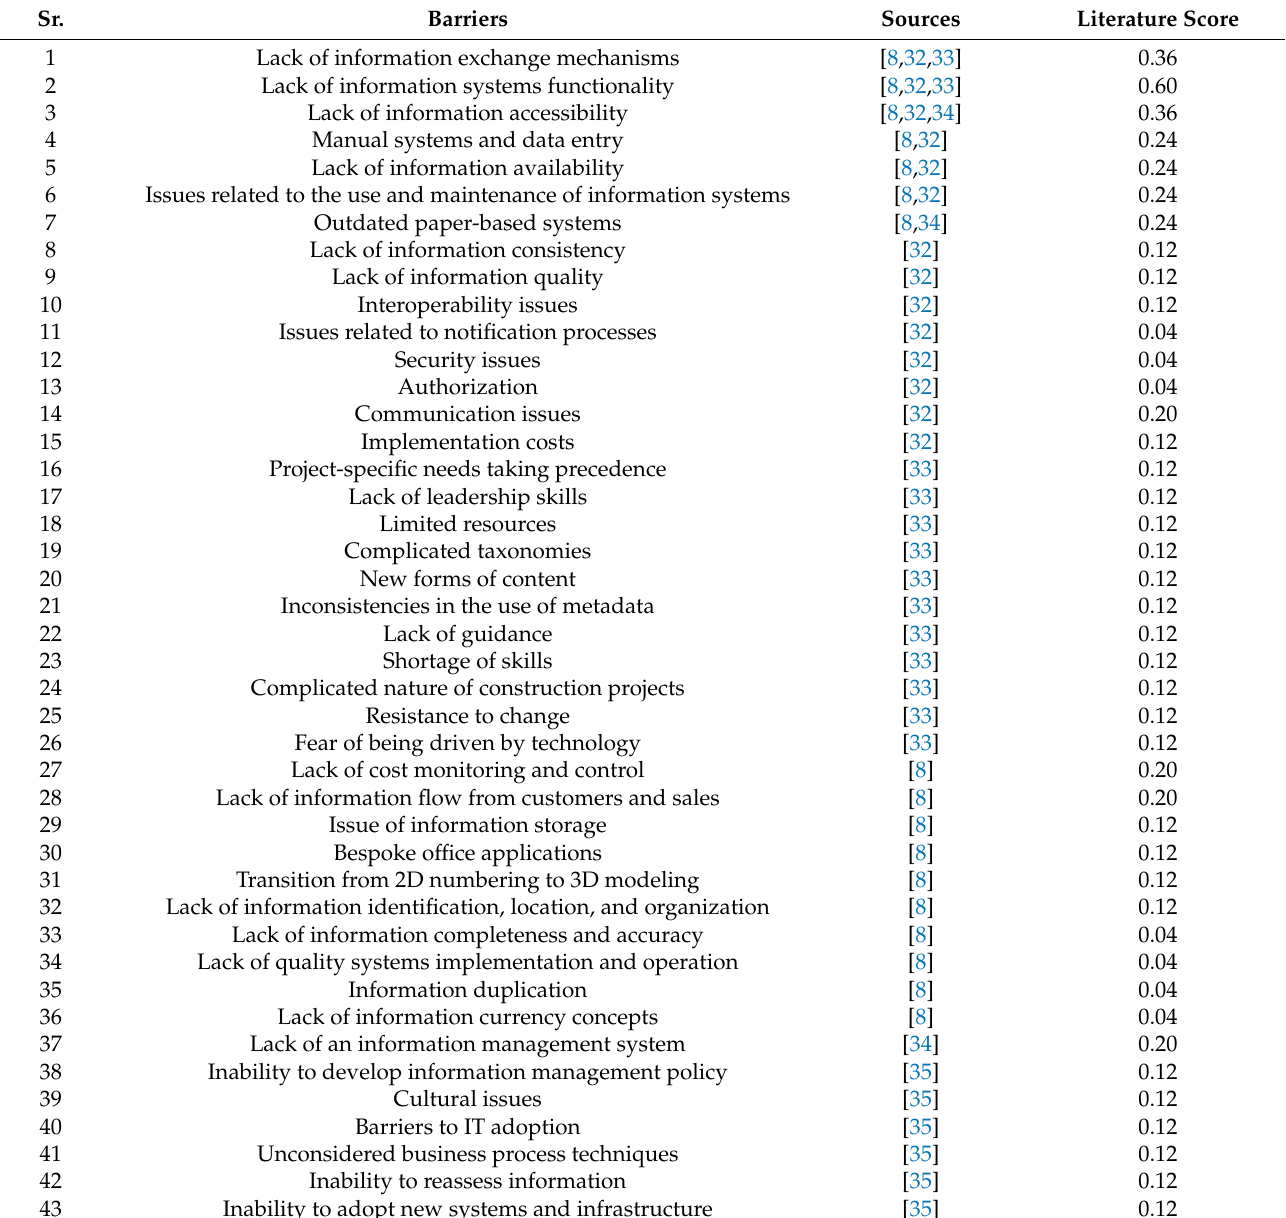
Table 1. Barriers to information management.